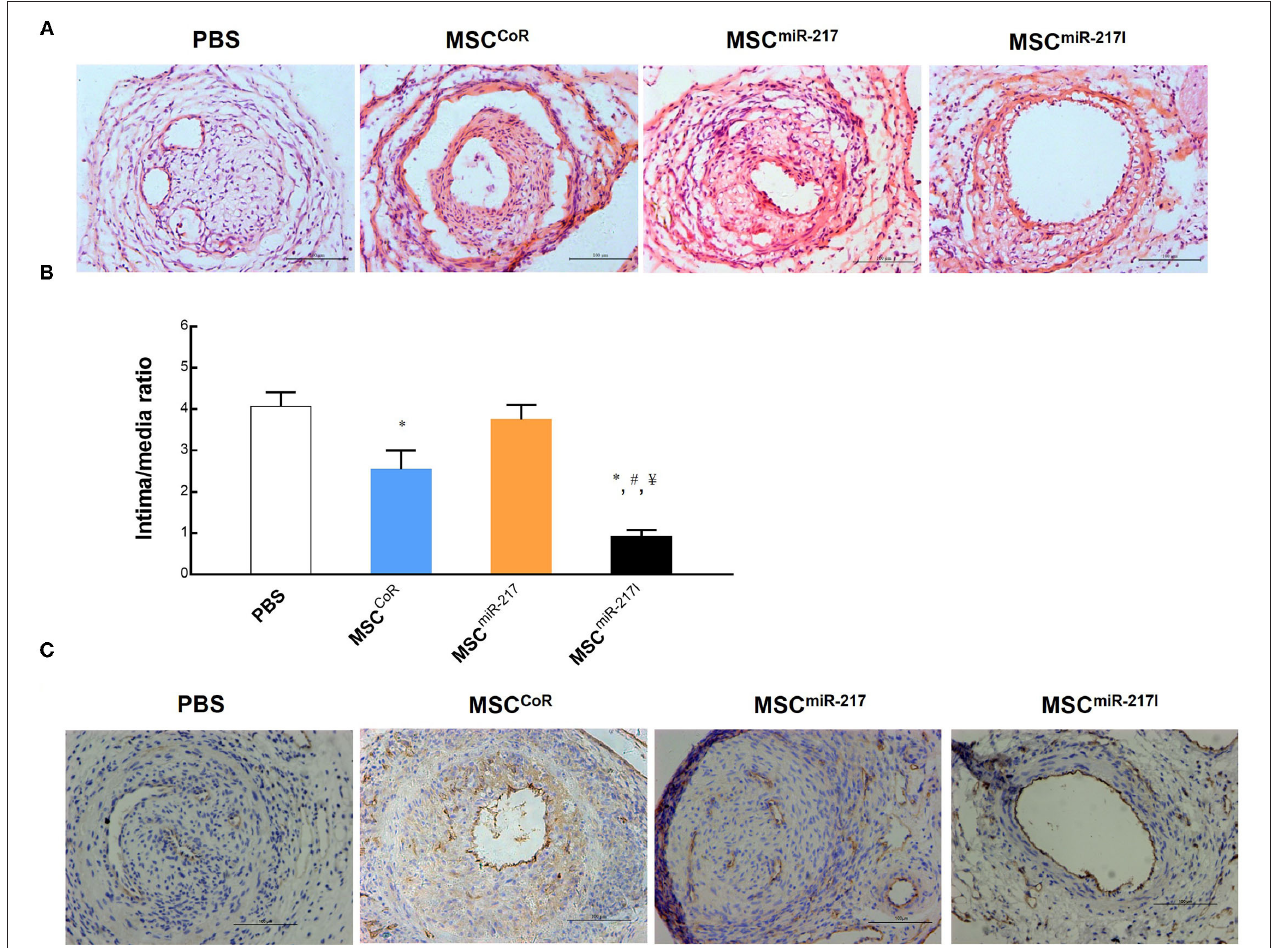
FIGURE 3 | Evaluation of the therapeutic effect of MSC injection on re-endothelialization of the injured vasculature and the role of miRNA-217 in the injured artery repairment process. (A) Representative images of injured femoral arteries at 3 weeks after treatment with PBS, MSC CoR (MSCs transfected with control siRNA), MSC miR − 217 , MSC miR − 217I . Scale bars = 100 µ m. (B) Analysis of the intima-to-media thickness ratio to reveal the cell treatment effect for neointima formation. * P < 0.05 vs. PBS, # P < 0.05 vs. MSC CoR , U P < 0.05 vs. MSC miR − 217 . n = 9 each. (C) Immunohistochemistry analysis of injured vessels for CD31 endothelial marker expression at day 21 after the surgery and cell